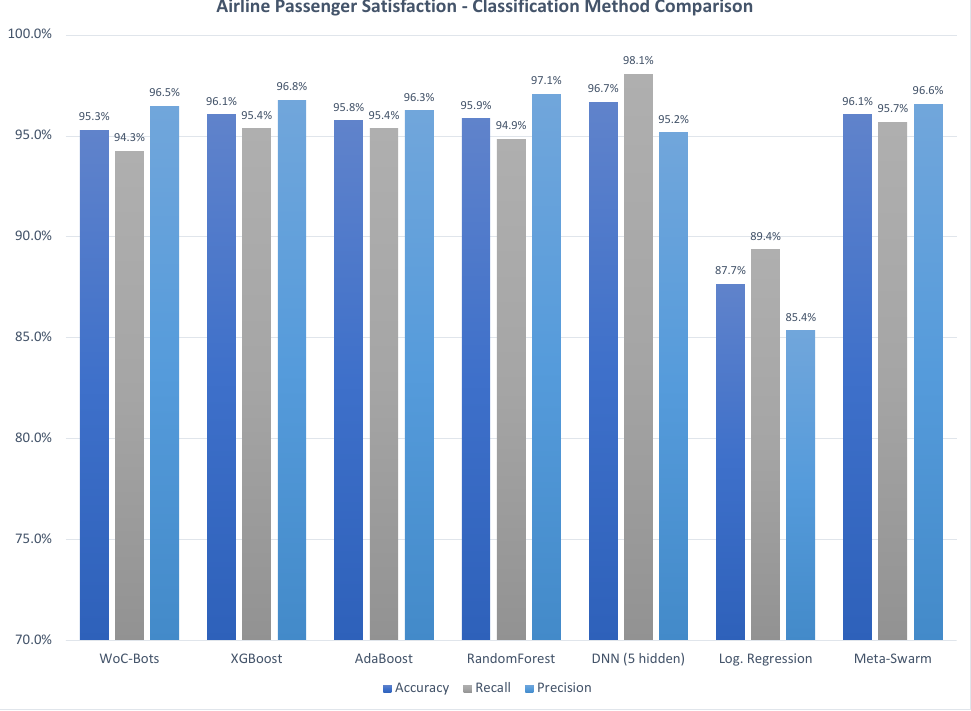
Figure 5. Comparison of five classification methods with two versions of the swarm (first and last columns) for the airline passenger satisfaction dataset. Table 7. Confidence Interval Distribution and Accuracy—Meta-Swarm for Airline Passenger Satisfaction. Interval n =